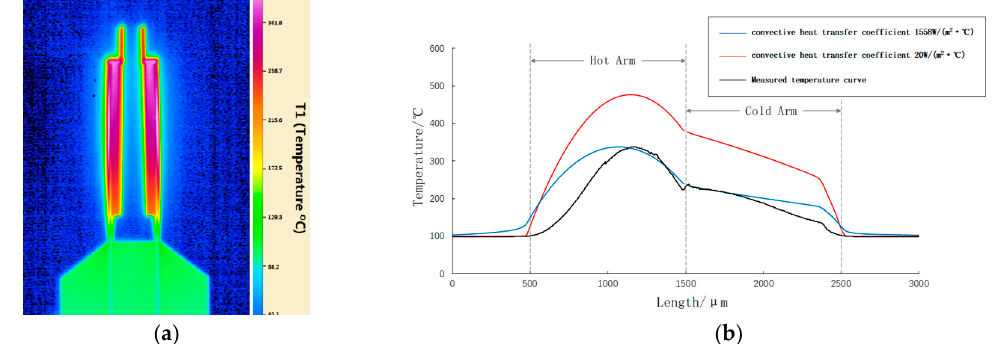
Figure 8. Comparison of the heat transfer parameters: ( a ) Measured temperature field of the microgripper; ( b ) comparison of the temperature curves.